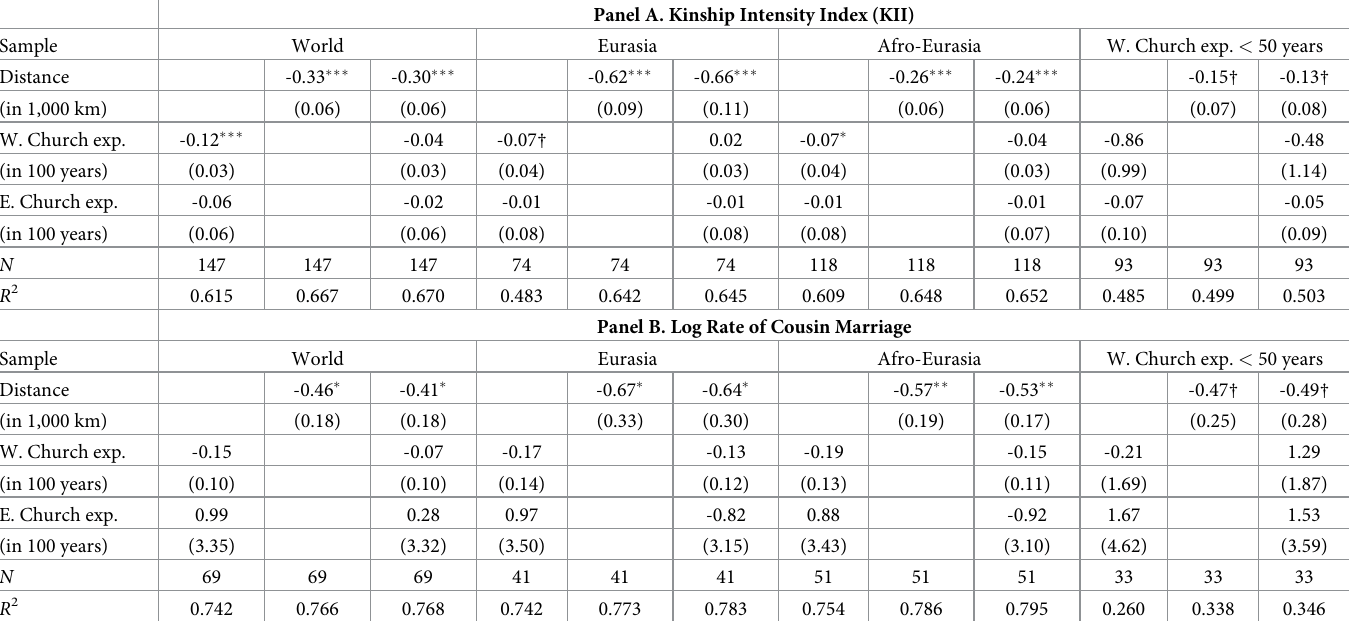
Table 1. Cross-country regressions of KII and cousin marriage on distance to innovations and Church exposure.